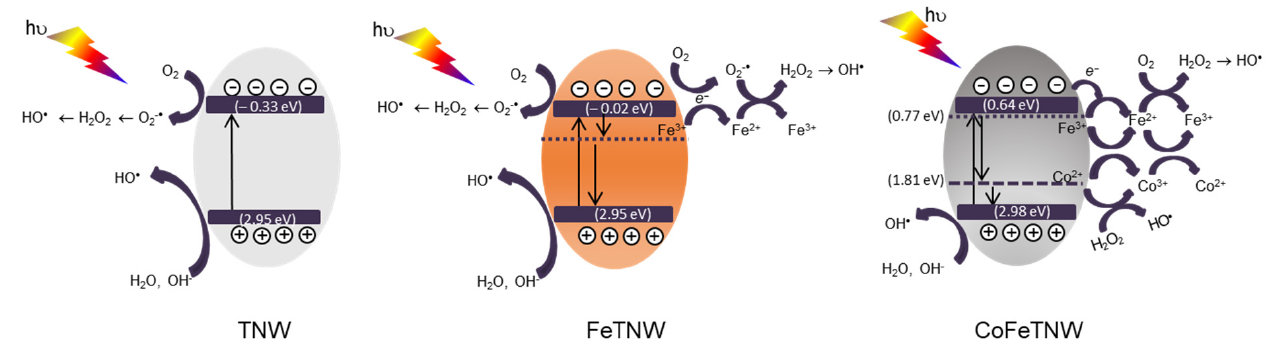
Figure 8. Photo-activation mechanism proposed for TNW, FeTNW and CoFeTNW hybrid nanoparti- cles.